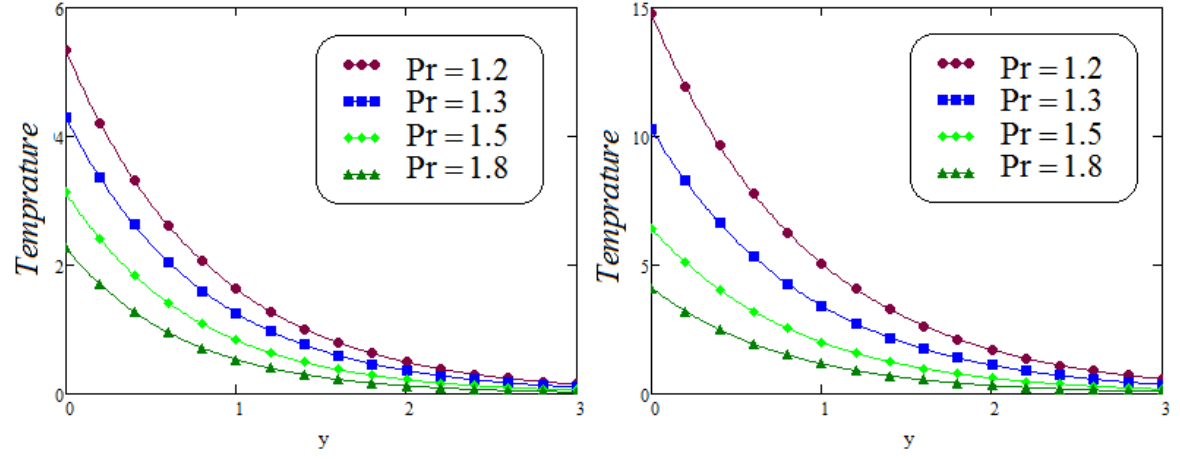
Figure 2. Temperature profile for varied values of P r for two different time levels t = 0.9 and t = 1.5. In Figures 3–10, velocity is plotted for the function f ( t ) = e at with and without slip effect γ for several values of dimensionless parameters M , Pr , Gr , λ 1 and λ 2 , by considering t = 1.5 and a = 0.25.